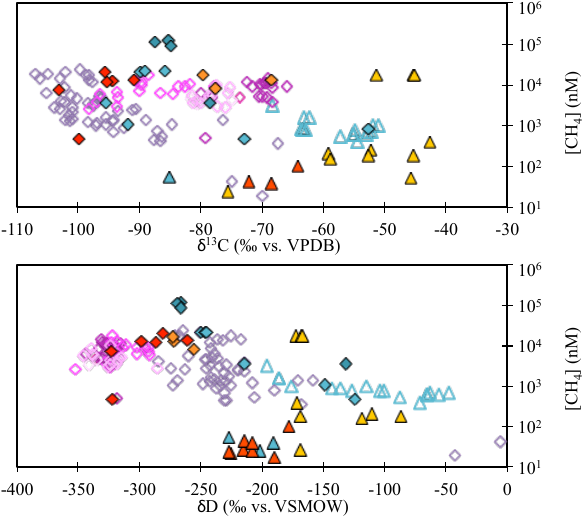
Figure 4. CH 4 concentration versus stable isotope plots. Water sampling (triangles), sediment cores (diamonds). Summer sampling (close symbols) and winter sampling (open symbols). Buor-Khaya Bay (purple, ID-11: non-ebullition site and IID-13, IIID-13 and VD13 hotspot sites), Dmitry Laptev Strait (red and orange), Lena Delta (light blue) and Shelf Edge (yellow) (see Fig. 1 for detailed locations and Table S1 for bathymetric information).